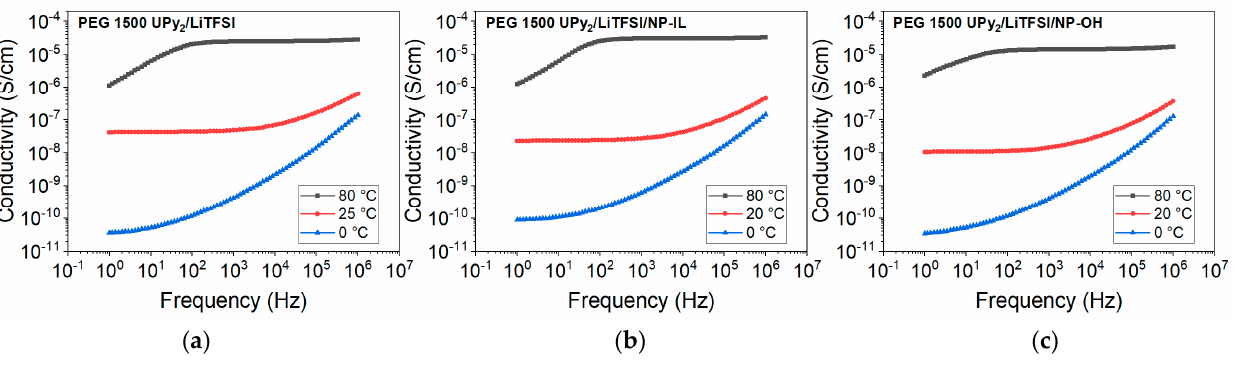
Figure 9. Frequency dependent ionic conductivity of ( a ) PEG 1500 UPy/LiTFSI mixture (EO:Li 5:1)( 1 ); ( b ) PEG 1500 UPy/LiTFSI (EO/Li 5:1) mixed with 15 wt% NP − IL ( 4 ); ( c ) PEG 1500 UPy/LiTFSI (EO/Li 5:1) mixed with 15 wt% NP − OH ( 7 ).